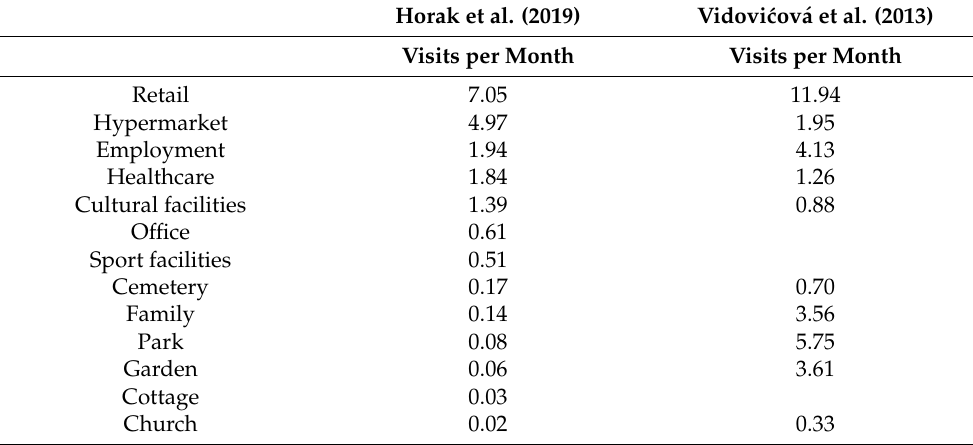
Table 1. Average number of visits per month for